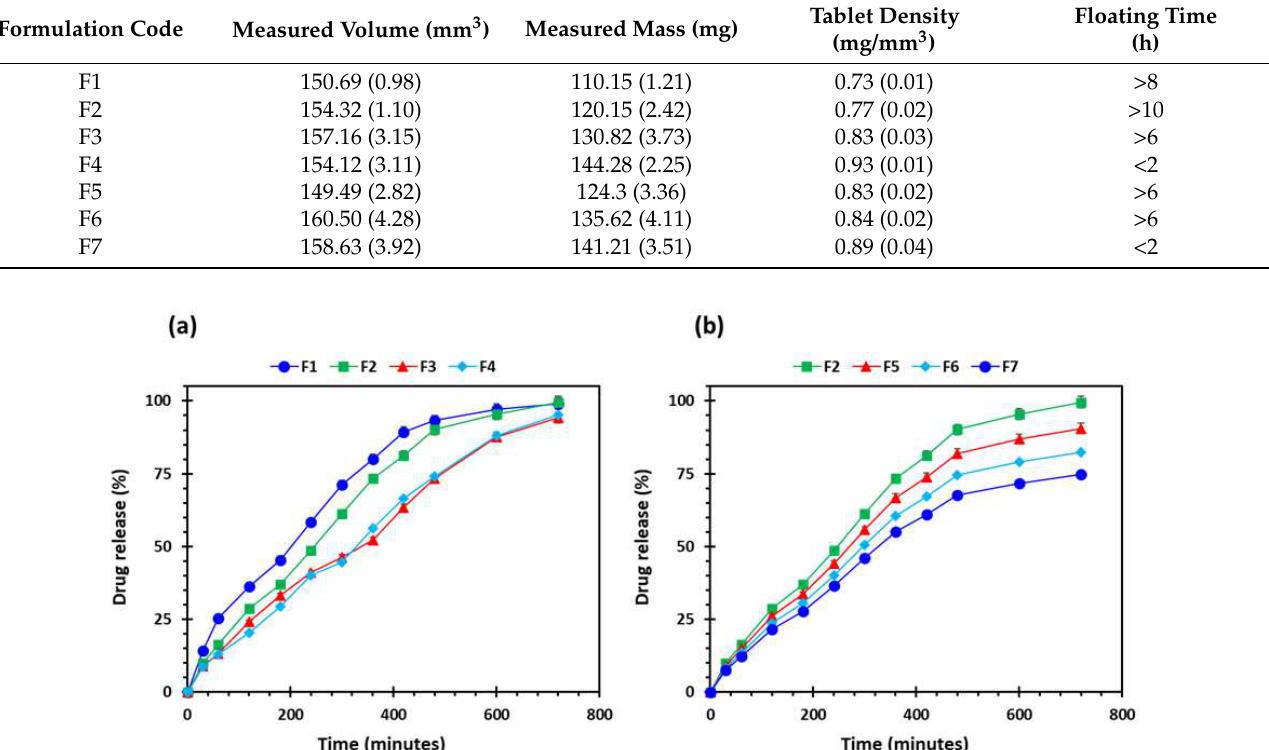
Figure 11. Drug release profiles of the 3D-printed tablets (n = 5): ( a ) the effect of number of shells; and ( b ) influence of percentage infill: F1 (1 shell with 0% infill); F2 (2 shells with 0% infill); F3 (3 shells with 0% infill); F4 (4 shells with 0% infill); F5 (2 shells with 10% infill); F6 (2 shells with 20% infill); and F7 (2 shells with 30% infill).